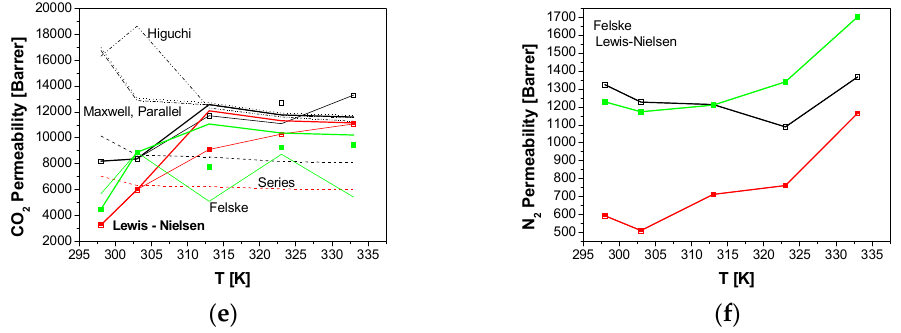
Figure 2. Comparison of CO 2 (left) and N 2 permeabilities through CHA ( a , b ), LTA ( c , d ) and RHO ( e , f )/PTMSP MMMs with the predictions by the series (dashed lines), parallel (dotted lines), original Maxwell (dash-dot), Higuchi (dash dot dot), Felske (thin continuous line) and Lewis–Nielsen (thick continuous line) models, as a function of temperature. Zeolite loading: 5 wt % (black), 10 wt % (red), 20 wt % (green).